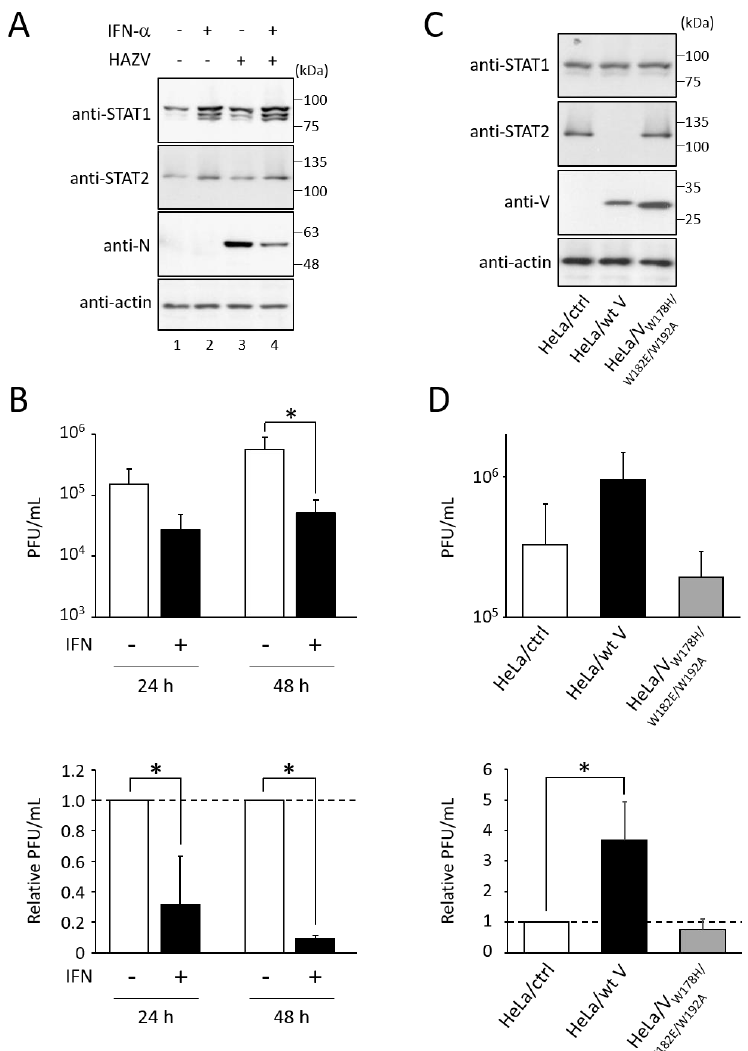
Figure 1. Effects of IFN on the growth of HAZV. ( A ) HeLa cells were stimulated with 1000 U/mL of IFN- α for 24 h, and were then infected with HAZV at an MOI of 0.1. After 24 h, cell lysates were subjected to immunoblot using the indicated Abs. Actin was used as a loading control. ( B ) The number of viruses in the culture supernatant of HAZV-infected cells after IFN- α treatment as in ( A ) was determined by plaque assay. The values of PFU/mL are the means from three independent experiments. Data are also shown as relative values (-IFN = 1). p values were calculated by the Student’s t -test. * p < 0.05, compared to values of -IFN. Error bars indicate standard deviations. ( C ) Lysates of HeLa cell lines constitutively expressing wt V of hPIV-2 (HeLa/wt V) or V W178H/W182E/W192A (HeLa/V W178H/W182E/W192A ), and their control cell line (HeLa/ctrl) were subjected to immunoblot using the indicated Abs. Actin was used as a loading control. ( D ) The cells were infected with HAZV at an MOI of 0.1 for 24 h, and virus titers were determined as described in ( B ). Data are shown as PFU/mL and relative PFU/mL (HeLa/ctrl = 1). p values were calculated by the Student’s t -test. * p < 0.05, compared to values of HeLa/ctrl.